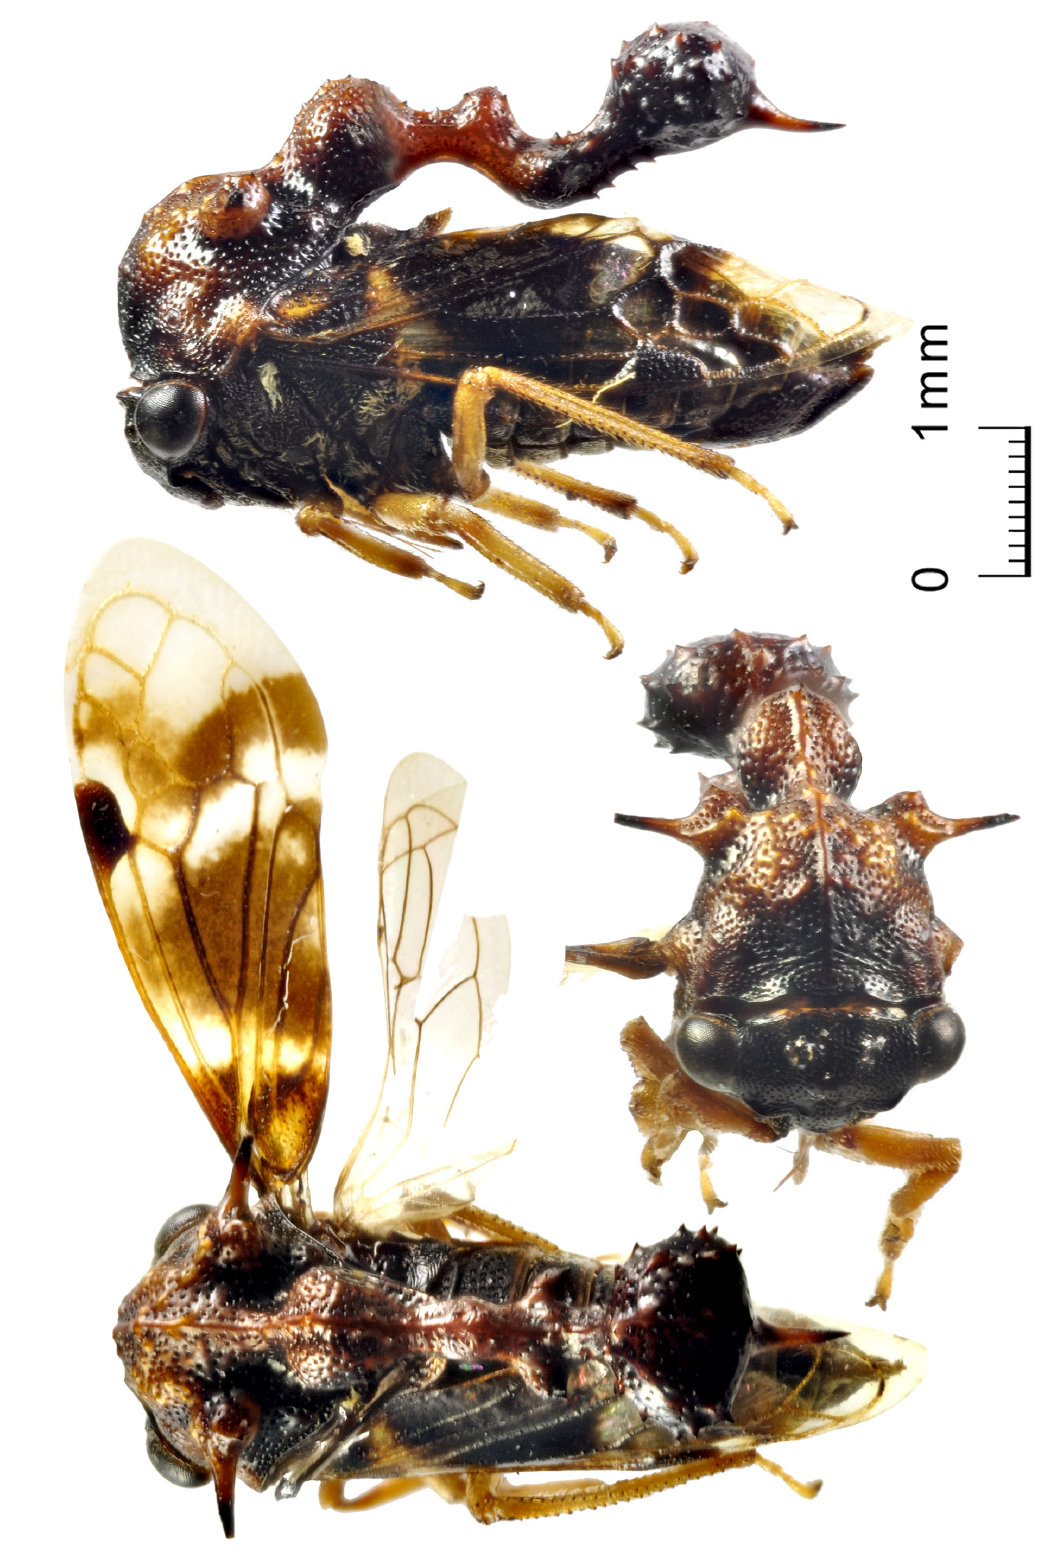
Fig. 3. Hamma caneparii sp. nov., holotype, ♀, Gabon, Ogoouè Lolo, Inzambò (Iboundji), m 427, 0.1°6′21.7″ S, 0.11°51′17.8″ E, 24 Nov. 2012, A. Susini leg.